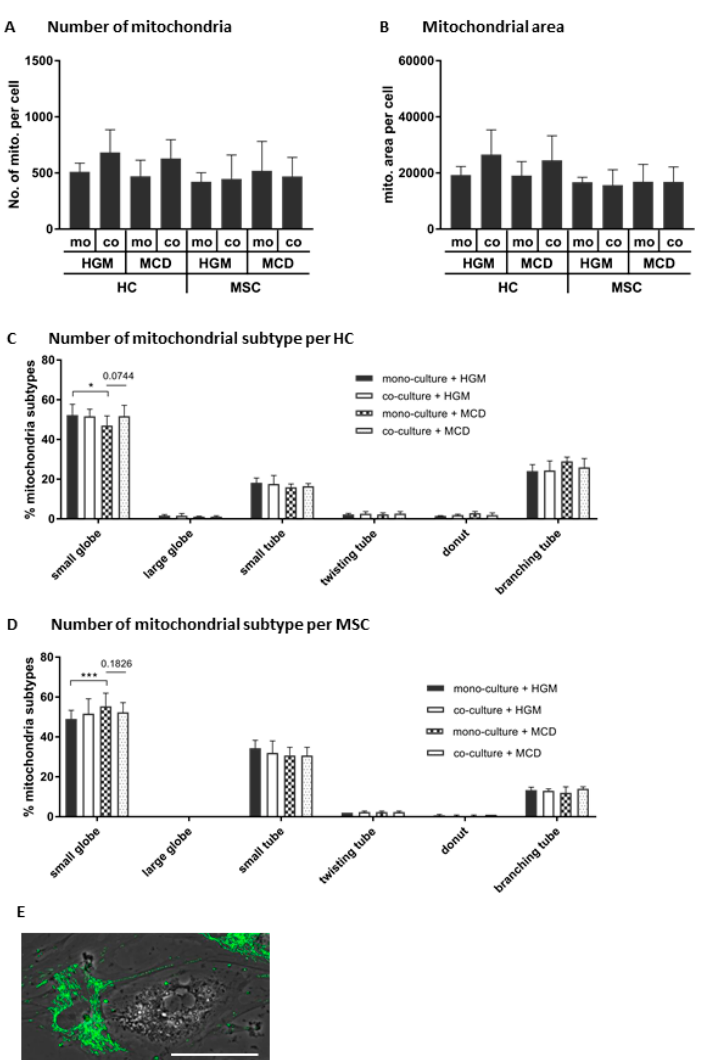
Figure 8. Profiling of cell-type-specific mitochondria in co-cultures of mouse hepatocytes and human MSCs. On day 1 of co-culture, fluorescence images of cells stained with MitoTracker Red CMXRos were analyzed for the ( A ) number and ( B ) area of mitochondria and percentages of mitochondria subtypes ( C ) in HCs and ( D ) in MSCs using the software MicroP. The statistical comparisons from 4 independent cell cultures were made using the 2-way ANOVA test. Results are expressed as mean ± SD. Statistical comparisons were made using unpaired t -tests, and di ff erences between groups were considered significant for the p -values *: p ≤ 0.05; ***: p ≤ 0.001. ( E ) The globular morphology of MSC mitochondria was confirmed (cf. also Supplementary Material file 2, Figure S7) in MSCs co-cultured with HCs in HGM or MCD medium. The mitochondria were stained (pseudo-colored in green) and the picture was merged with the light microscopy image. Scale bar 50 µ m. mo: mono-culture; co: co- culture.